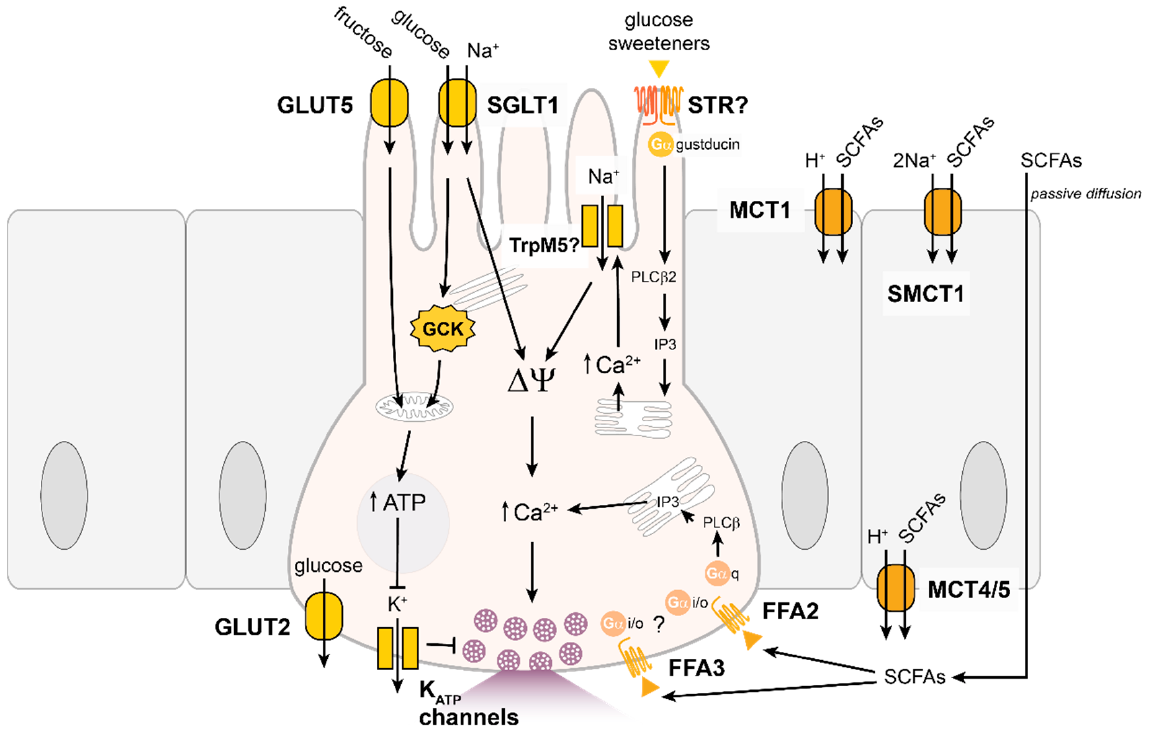
Figure 2. Carbohydrate-sensing mechanisms in incretin hormone secreting EECs. Schematic of EEC with apical process (top) and basolateral surface (bottom) populated with secretory vesicles containing incretin hormones. Enterocytes shown in grey beside EEC. Glucose sensing by incretin-secreting EECs is critically dependent on sodium coupled uptake via SGLT1. Other sensors have been described, but are controversial (labelled with a question mark) or appear to be of limited physiological relevance. When SGLT1 is inhibited, GLP-1 secretion is elevated at later time points, possibly downstream of fermentation to short-chain fatty acids, which target G-protein coupled fatty acid receptors FFA2 and FFA3. These have been depicted on the basolateral membrane in analogy to the location of FFA1 (see text for details). Transport mechanisms of SCFAs across the intestinal epithelium illustrated in enterocytes on the right. Abbreviations: ATP, adenosine triphosphate; FFA2 or 3, Free fatty acid receptors; GCK, glucokinase; GLUT2, glucose transporter 2; GLUT5, glucose transporter 5; IP3, inositol triphosphate; K ATP , ATP sensitive potassium channel; MCT1 or 4/5, monocarboxylate transporters; PLC β , phospholipase C beta; SCFAs, short-chain fatty acids; SGLT1, sodium-glucose linked transporter 1; SMCT1, sodium-coupled monocarboxylate transporter 1; STR, sweet taste receptor; TrpM5, transient receptor potential cation channel subfamily M member 5; ΔΨ , membrane depolarization.